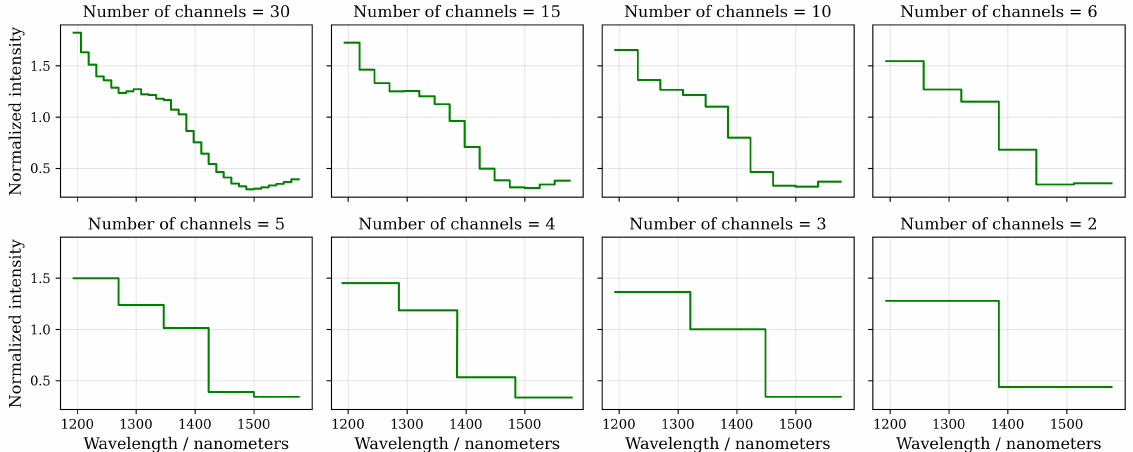
Figure 6. An example of channel binning with various bin widths N bins (sample class grass, normal- ized spectrum over 10,000 frames). The ability of the binned spectrum to approximate the original spectrum suffers as the bin width is increased (number of channels is reduced). On the other hand, the channel-wise signal level increases, improving the signal-to-noise